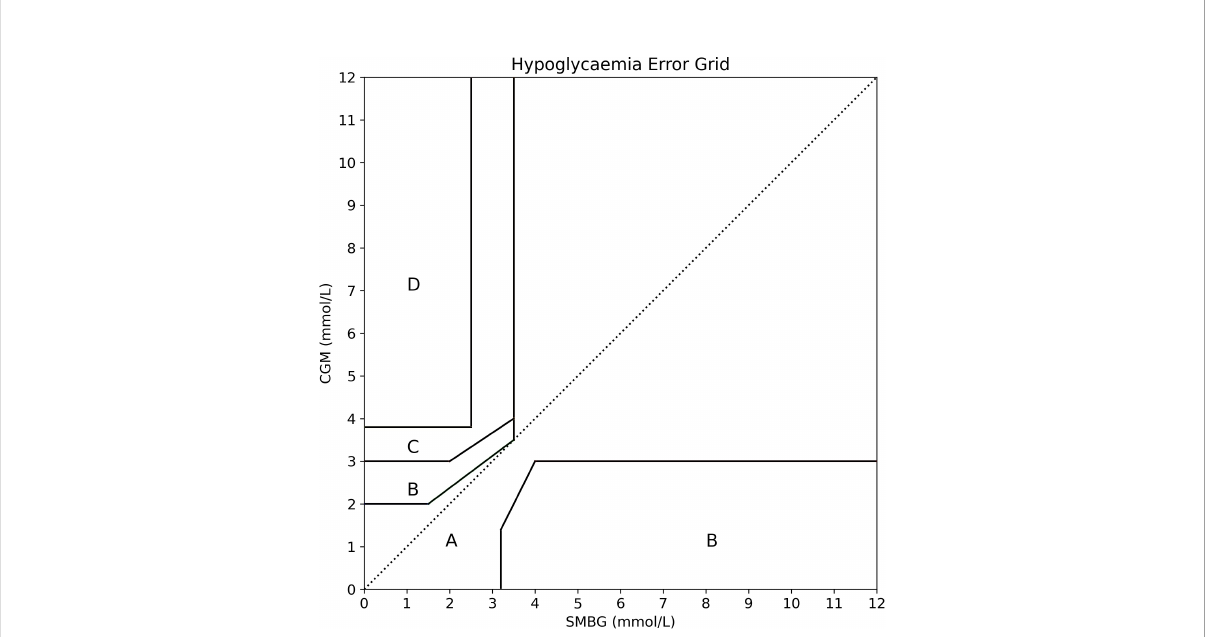
FIGURE 3 The new Hypoglycaemia Error Grid (HEG). Based upon the consensus opinion of 14 consultant paediatric endocrinologists working regularly with patients with CHI in the two UK centres of excellence. In contrast to error grids designed for use in diabetes, the HEG assigned relatively low risk to missed hyperglycaemia and relatively high risk to small errors around missed hypoglycaemia. As risks did not alter beyond 4.0mmol/ L, the grid was extended from 10mmol/L to 12mmol/L with the same lines to incorporate the occasional value in this